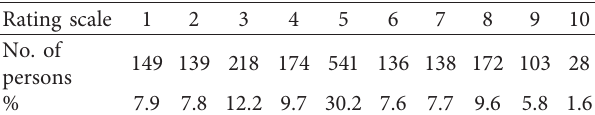
Table 7: IGSE administrators’ view on cut-down in face-to-face meetings thanks to the use of modern gadgets and messenger applications.